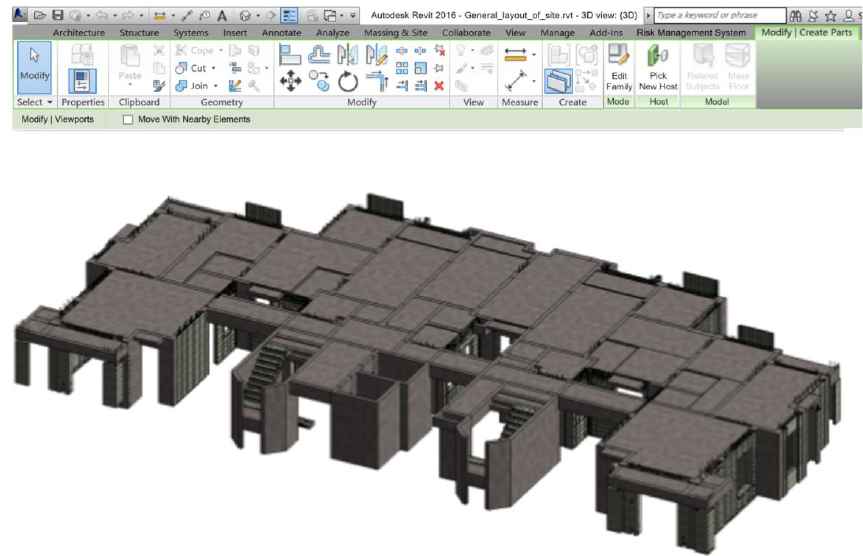
Figure 10. BIM model in the design stage.